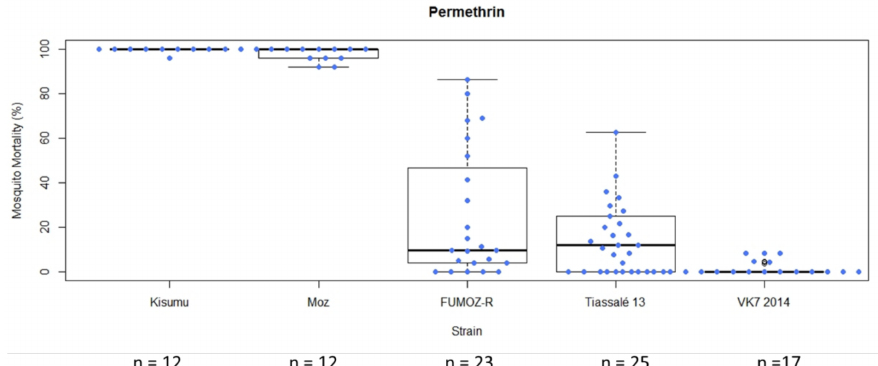
Figure 4. Box plot summarising mosquito mortality following exposure to permethrin 0.75% in a standard WHO tube bioassay in LITE strains. Each box represents a different mosquito strain. Coloured circles and n values indicate each tube replicate (not total mosquito numbers).